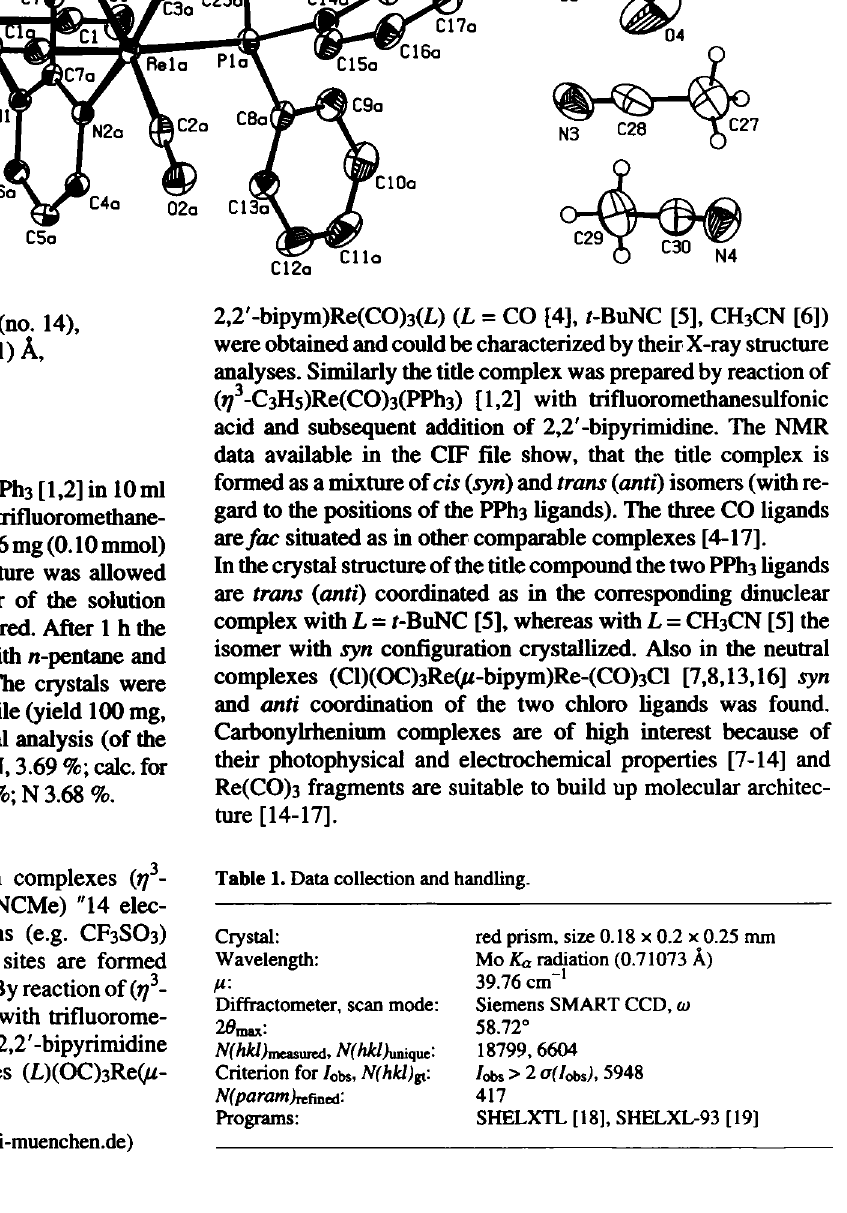
Table 1. Data collection and